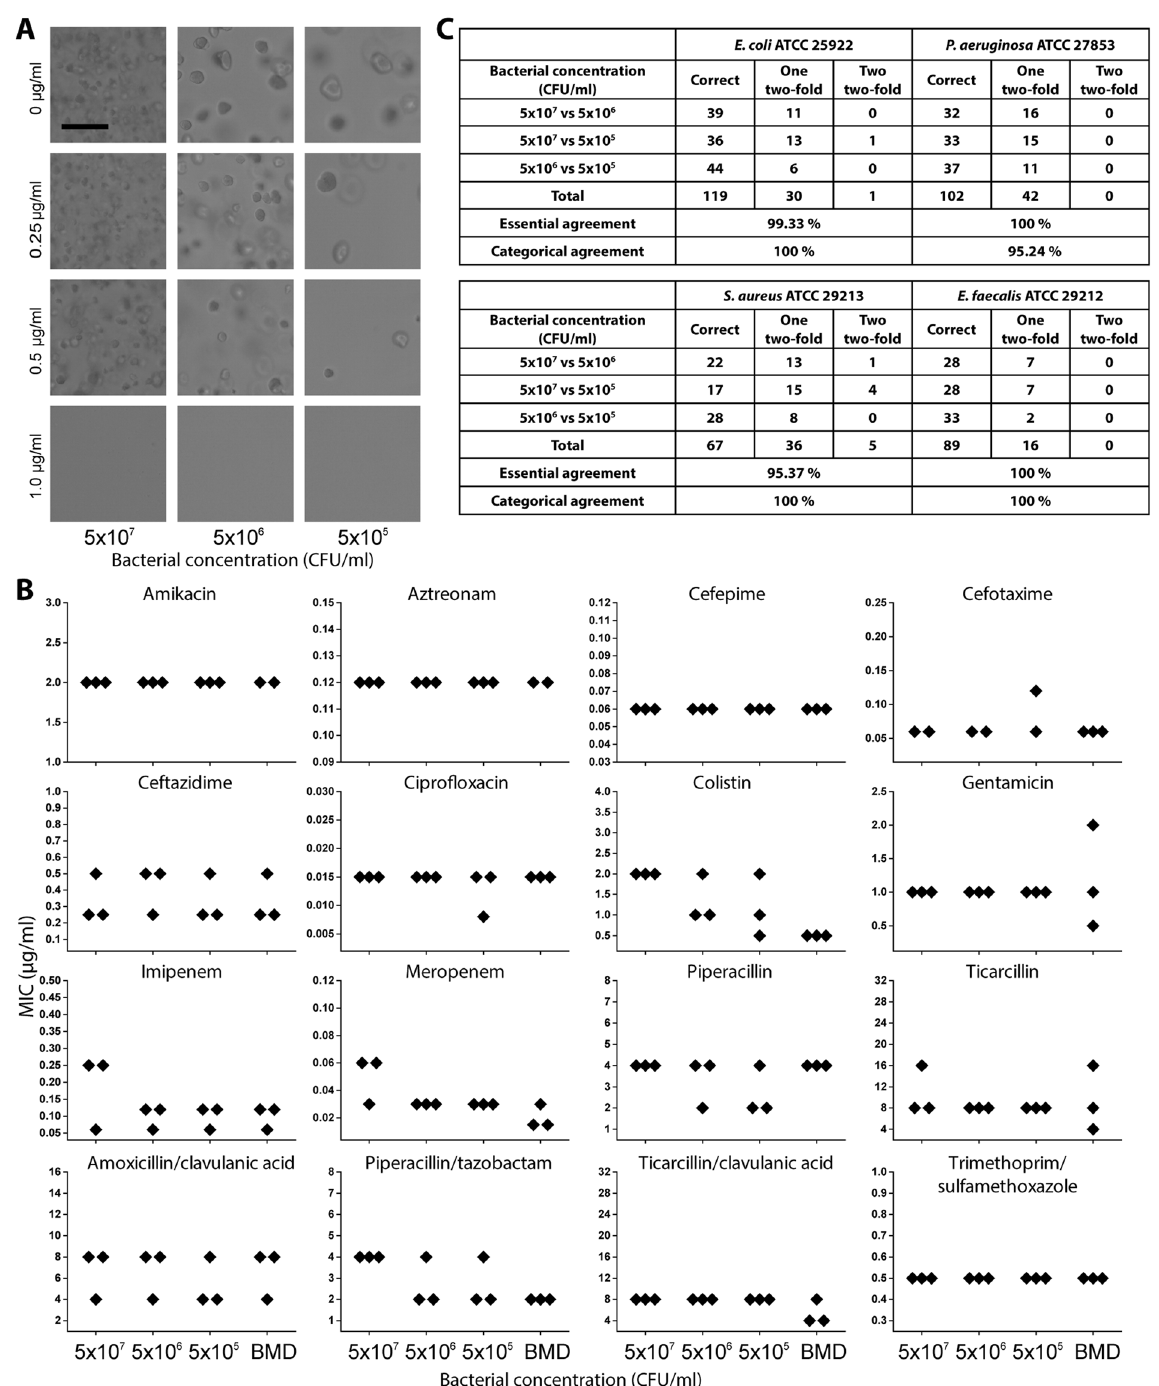
Figure 2. Consistent AST results from a wide range of inoculum sizes. ( A ) Colony formation of bacteria at different inoculum sizes. In all inoculum sizes from 5.0 × 10 7 to 5.0 × 10 5 CFU/ml, there was microcolony formation at 0, 0.25 and 0.5 μ g/ml gentamicin. At 1 μ g/ml gentamicin, there was no colony formation at any inoculum size. The scale bar represents 100 μ m. ( B ) MIC values from different E. coli ATCC 25922 inoculum sizes of 5.0 × 10 7 , 5.0 × 10 6 and 5.0 × 10 5 CFU/ml incubated with 17 clinically important antimicrobials and analyzed using dRAST and broth microdilution test. For all inoculum sizes, the MIC values were in the middle of the CLSI quality control ranges. (C) Summary of a comparison of AST results from various inoculum sizes of E. coli ATCC 25922, P. aeruginosa ATCC 27853, S. aureus ATCC 29213 and E. faecalis ATCC 29212. “Correct” means a case with identical MIC values from different inoculum sizes. “One two-fold” and “Two two-fold” denote cases with MIC values from different inoculum sizes that were different by two-fold and four-fold, respectively. “Essential agreement” refers to the proportion of cases that were correct or had one two-fold difference. The essential agreement rates were 99.33% in E. coli ATCC 25922, 100% in P. aeruginosa ATCC 27853, 95.37% in S. aureus ATCC 29213 and 100% in E. faecalis ATCC